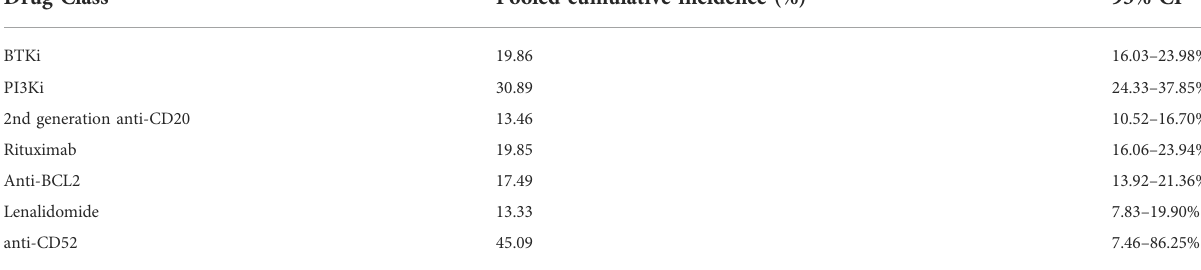
TABLE 1 Pooled cumulative incidence of severe